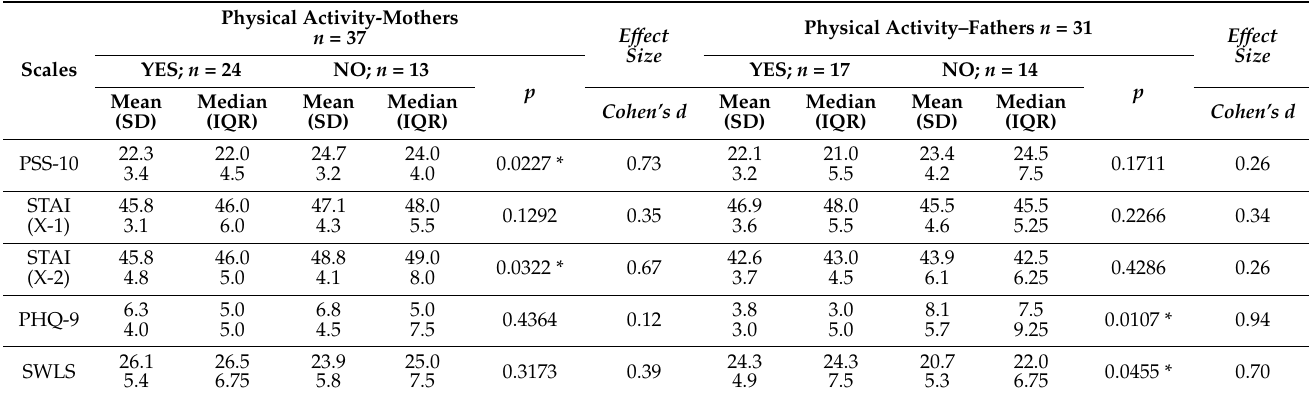
Table 4. Results of selected scales in relation to declared physical activity in the groups of mothers and fathers surveyed (Mann–Whitney U test).